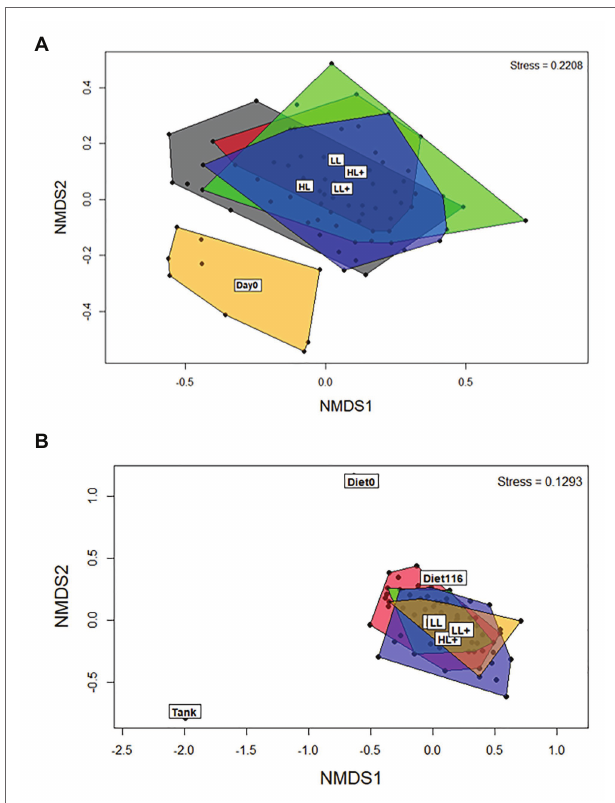
FIGURE 3 | Non-metric dimensional scaling (NMDS) plots of bacterial beta-diversity from the distal intestine of Atlantic salmon fed HL or LL diets with or without additional n-3 PUFA (+). Oxygen conditions were pooled together and fish were sampled on (A) day 0 ( N = 9) and 35 ( N = 72), and (B) day 116 ( N = 72). Intestine samples were compared to the commercial diet (Diet0), pooled experimental diets (Diet116), and tank biofilm (Tank; N =